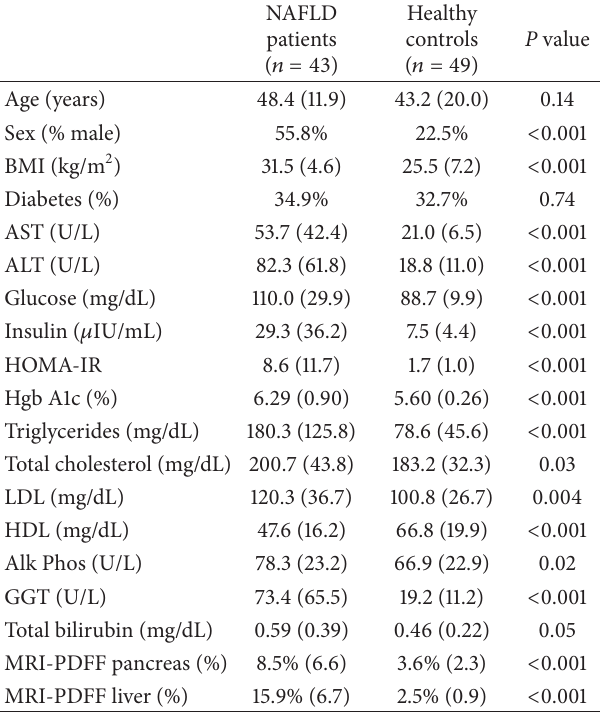
Table 1: Demographic and biochemical characteristics of patients with NAFLD and healthy